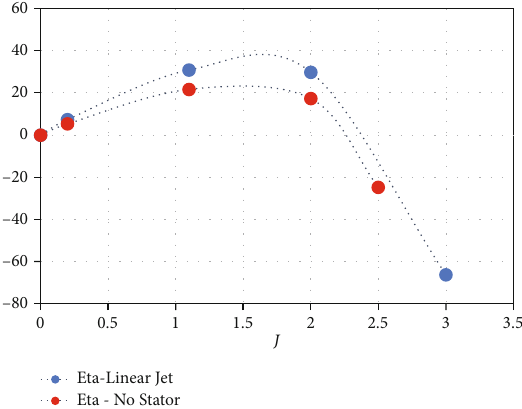
Figure 14: Comparison of e ffi ciency in the presence and absence of a stator.